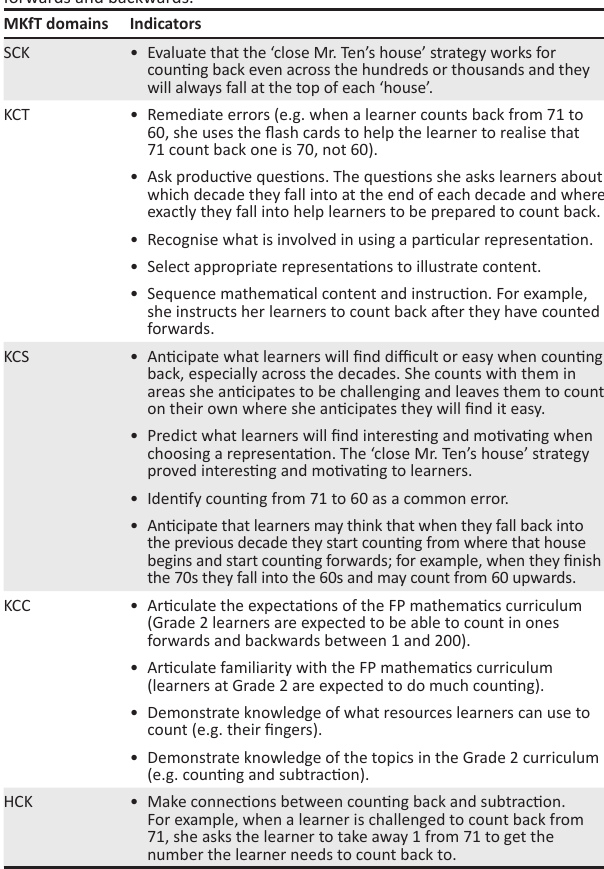
TABLE 3: Summary of the mathematics knowledge for teaching domains prevalent in development of bridging the decuples concept while counting forwards and